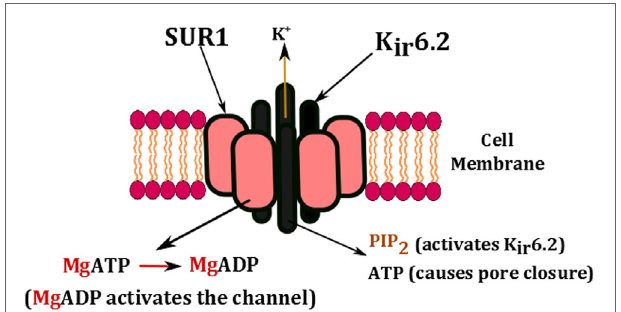
FiGURe 2 | Nucleotide regulation of K ATP channels . The channel is activated by the presence of PIP 2 and the conversion of MgATP to MgADP. High concentrations of ATP block the pore and cause channel